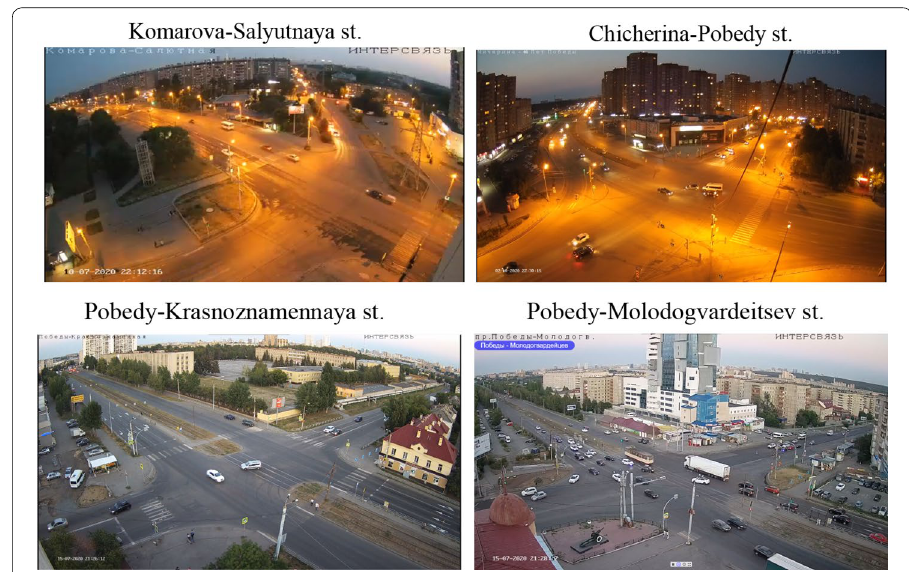
Fig. 16 Overview of intersections from CCTV cameras